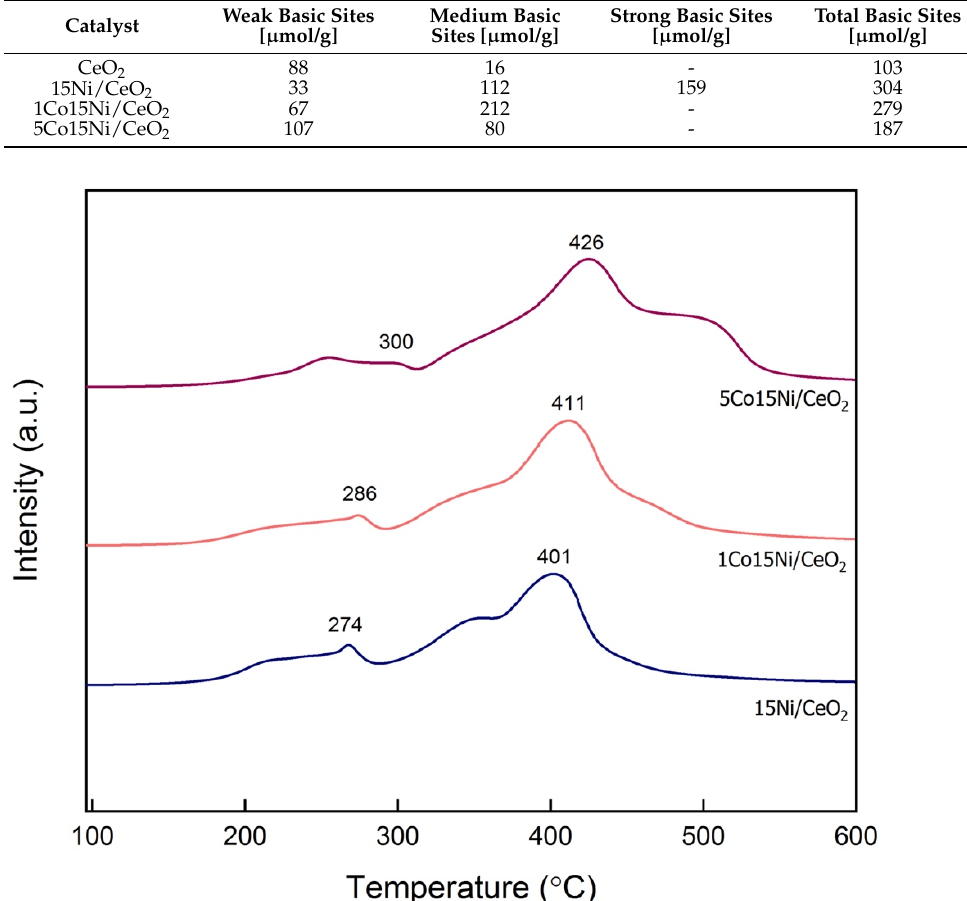
Figure 1. H 2 -TPR profiles for calcined samples with different Co content. Table 1. Comparison of reduction peaks for similar catalysts with different contents with present study.